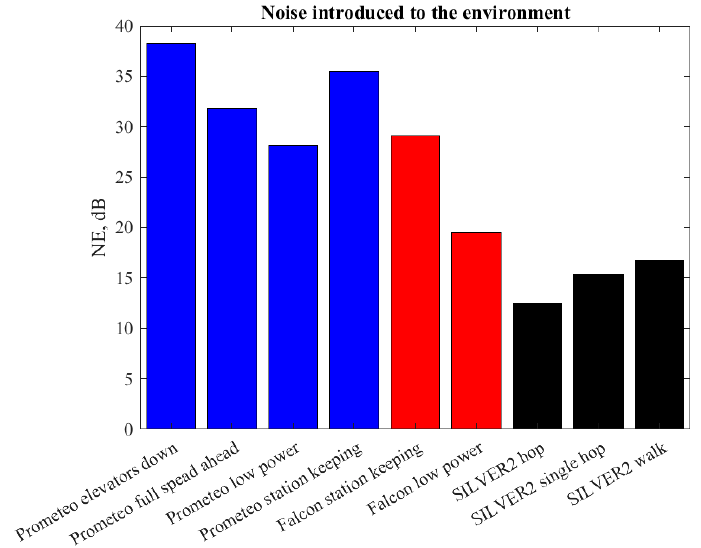
Figure 7. Noise introduced to the environment by Prometeo (blue), Falcon (red), and SILVER2 (black) performing different maneuvers.